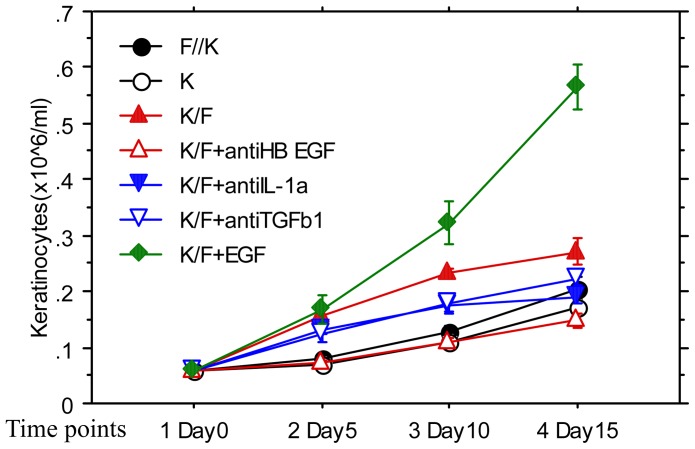
Effects of co-cultures on the growth of Keratinocytes in long term culture.Keratinocytes were cultured with fibroblasts in common 6-well plates (K/F), with Fibroblasts in transwell to separate keratinocytes and fibroblasts (K//F), with 20ng/ml EGF (K+ EGF), with fibroblasts and anti-HB EGF (K/F + anti-HB EGF), anti-IL-1α (K/F + antiIL-1a) or anti-TGFβ1 (K/F antiTGF β1) or keratinocytes alone (K). 6-well-plates were used in the culture and cells were resuspended in 12 ml after harvested. Four cultures in each condition. Keratinocytes and fibroblasts were respectively stained with PKH26 and PKH2 before culture and counted at the end of each culture (stage) by Trypan Blue exclusion and Flow Cytometry.